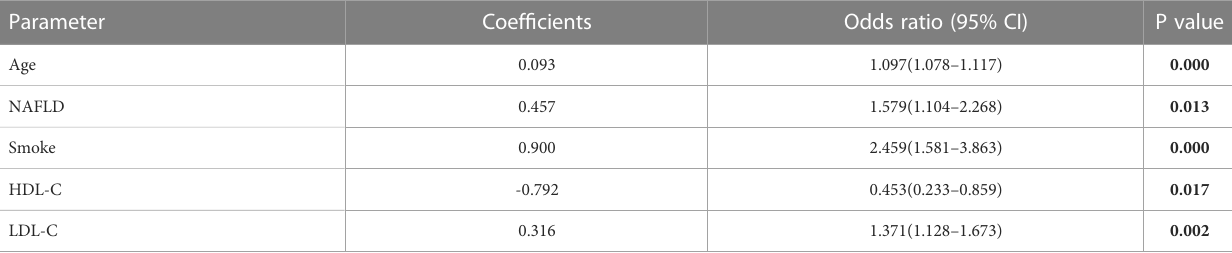
TABLE 4 Multivariate logistic regression analysis.